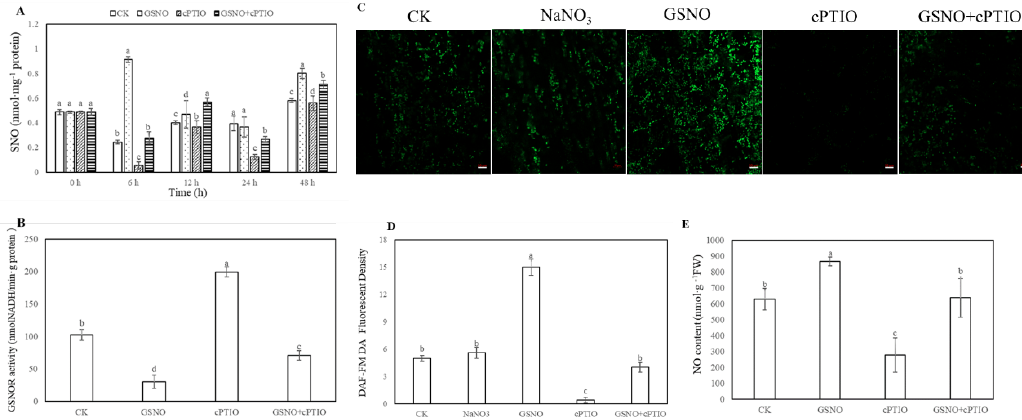
Figure 3. Effect of GSNO on the levels of total S -nitrosothiol (SNO) ( A ), S -nitrosoglutathione reductase (GSNOR) activity ( B ) and endogenous NO level ( C, D, E ) during the development of adventitious roots in cucumber. Explants were incubated with distilled water (CK) or 100 μM NaNO 3 , 200 μM cPTIO, 50 μM GSNO, or 50 μM GSNO + 200 μM cPTIO. The levels of total SNO ( A ) were determined during adventitious rooting. GSNOR activity ( B ) and endogenous NO levels ( C, E ) in cucumbers were detected after 6 h of treatment. 4-amino-5-methylamino-2′,7′- di aminofluoresceindiacetate (DAF-FM DA) was utilized to detect endogenous NO of a longitudinal section from the tip of the hypocotyls. Changes in fluorescence intensity of NO ( C ) were monitored by fluorescence microscopy after 6 h. The DAF-FM DA fluorescence density of endogenous NO ( D ) was analyzed by ImageJ software. Bars with different lowercase letters were significantly different by Duncan’s multiple range test ( p < 0.05). Bars with different lowercase letters were significantly different by Duncan’s multiple range test.